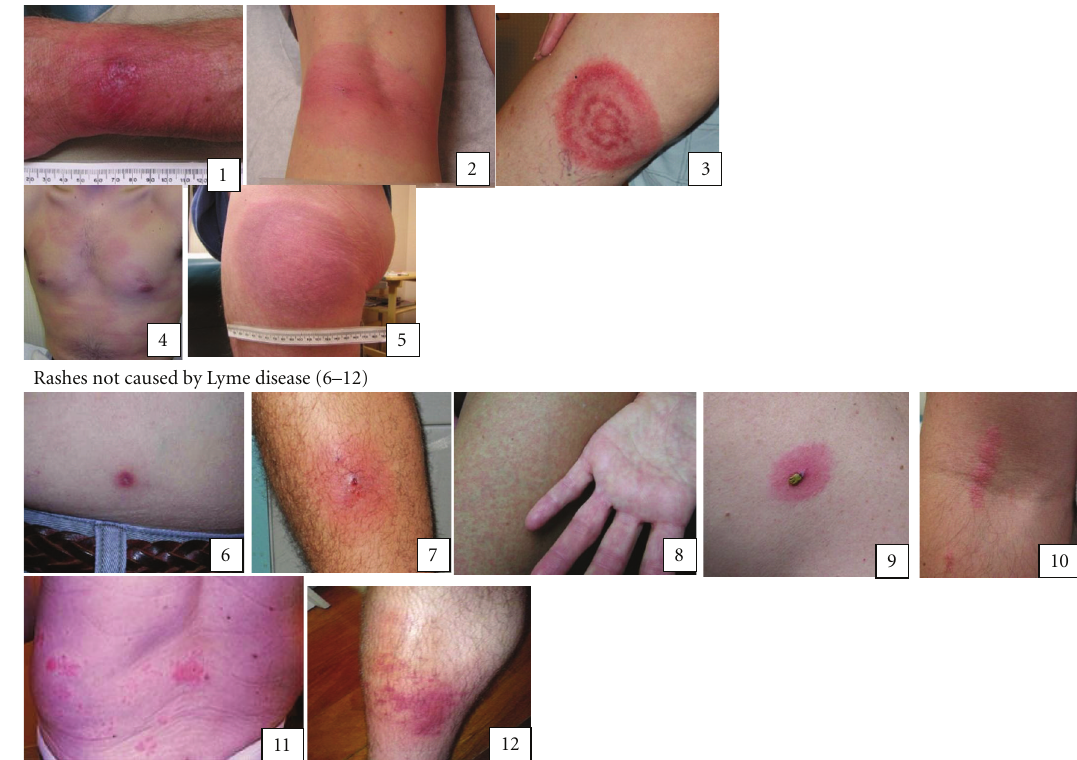
Figure 1: Rash photographs included in the website